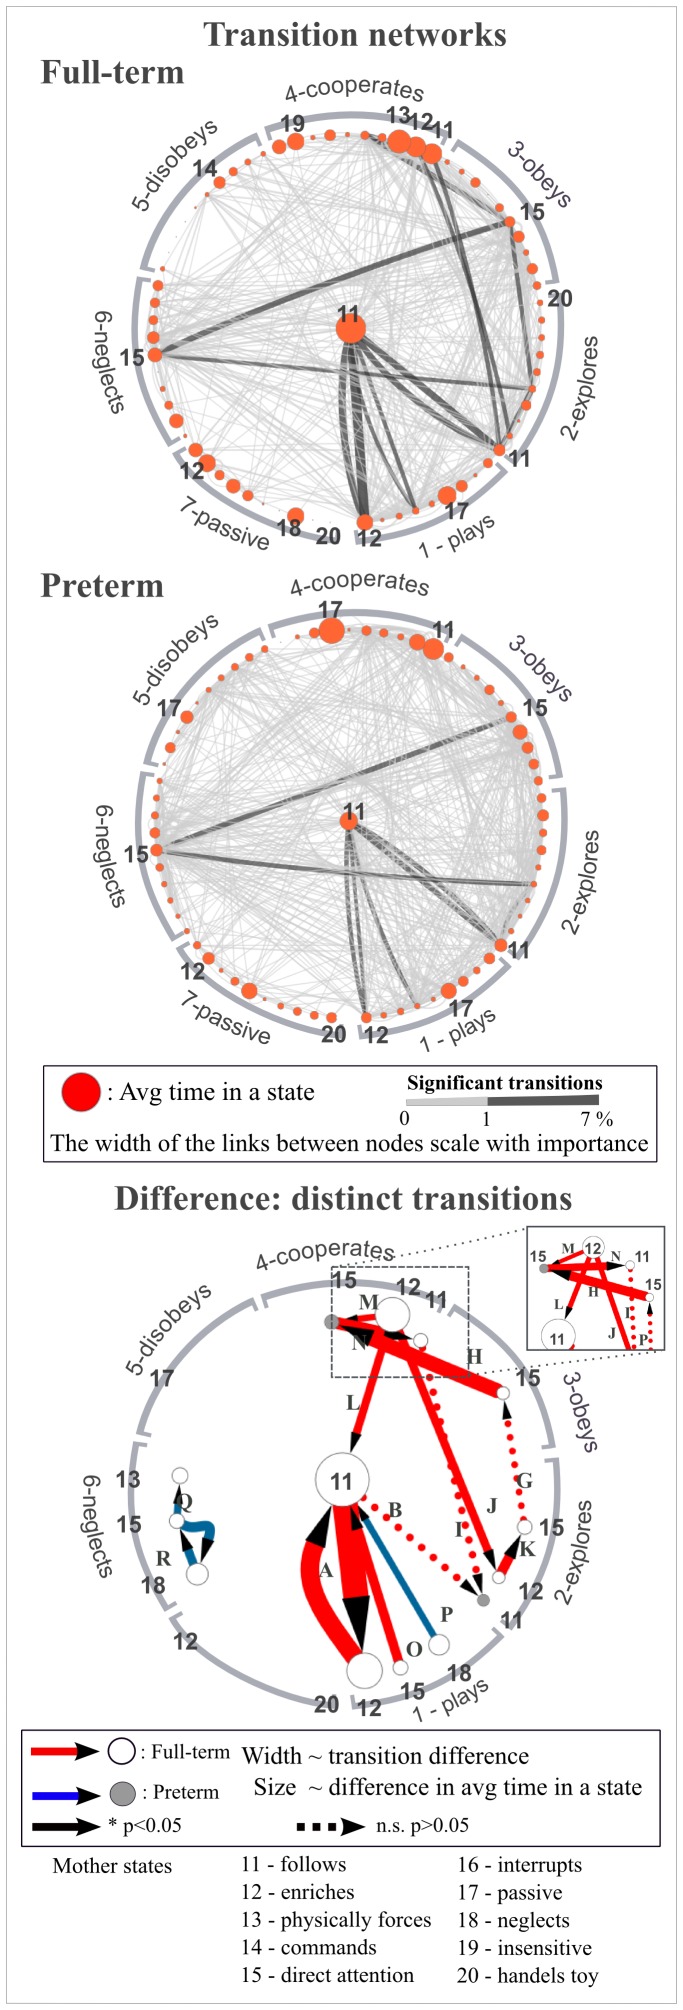
Interaction networks of the combined mother-infant behavioral transitions in full-term (top panel) and preterm (middle panel).Nodes (red circles) represent combined mother-infant behavioral states and their size is a measure of the average time spent in the combined state. The combined states are attributed an infant state (1 to 7, indicated in the outer ring) and a mother state, (11 to 20, listed to the right, and shown sequentially for each infant state). Links between the nodes indicate observed transitions from one combined state to another. The width and color of links change according to the transition rates, normalized within the group of either full-term or preterm (see the color scale). Transitions with probability less than 1% are bold. Bottom panel: The difference between the full-term and preterm transition networks. Arrows indicate transitions which have at least 0.5 transition rate in the full-term (red) or in the preterm (blue) network. Non-significant transitions are indicated by dotted arrows. The width of the links scale with the values of the transition differences and the node sizes scale with the absolute difference in time spent in the states. Dark grey nodes indicate states in which preterm infants/mothers spent the longer time whereas white nodes indicate states where full-term infants/mothers spent the longer time.